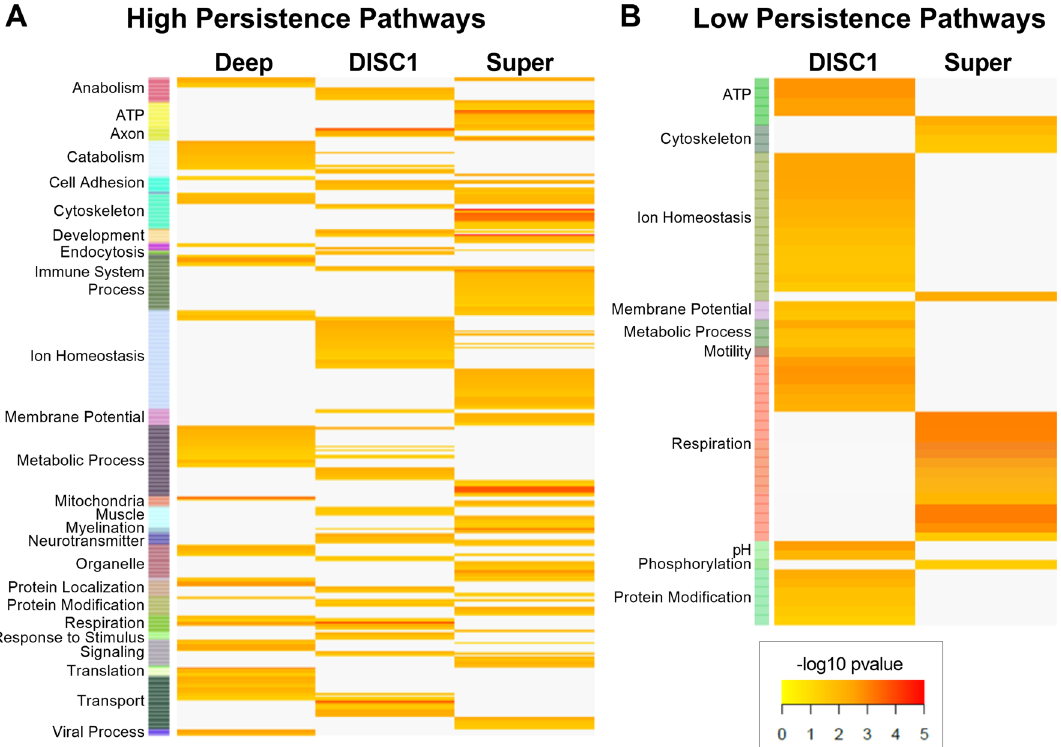
Figure 4. Persistent pathways in SCZ. Heatmaps of significant ( p < 0.05) pathways associated with ( A ) high and ( B ) low persistence genes. Pathways have been assigned to functional categories, summarizing their major functions and indicating processes that are expected to be of high or low importance in SCZ, respectively. Figures produced using gplots 49 .